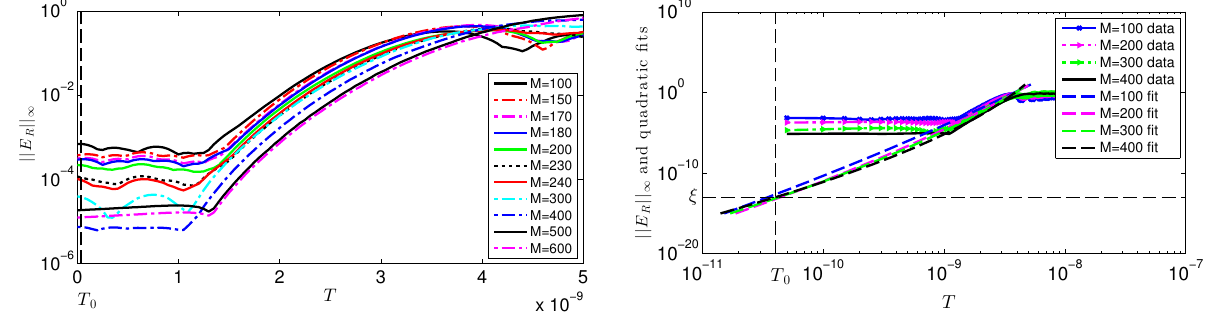
|| for various M in the DDR4 module with R ∞ = 0 . 04 ns 0 || together with their R ∞ = 0 . 040841 ns. 0